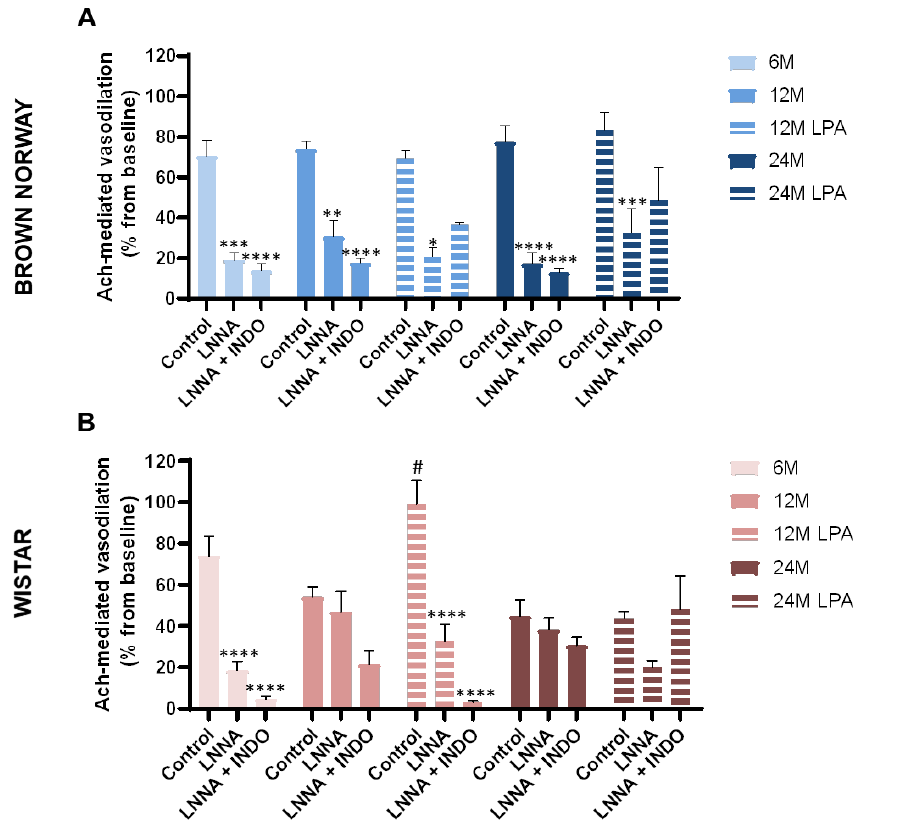
Figure 7. Evolution of the contribution of the NO synthase (NOS) and cyclooxygenase (COX) pathways in the Ach-mediated vasodilation over time with (hatched bars) or without (solid bars) LPA treatment. The effect of an NOS inhibitor (LNNA) in combination or not with a COX inhibitor (INDO) was analyzed on the vascular response to acetylcholine (Ach) iontophoresis in both BN ( A ) and Wistar strains ( B ) for 6 month old (6 M), 12 month old (12 M), and 24 month old (24 M) rats previously fed a diet supplemented with α -lipoic acid (0.5%) for 4 weeks (LPA) or not. In each condition, the blood flow was measured 1 min before and 16 min after iontophoresis. This allowed determining the vasodilation in response to Ach iontophoresis following injection of saline (control) and LNNA alone or in combination with INDO. Results were obtained as a percentage increase from baseline. Error bars represent the standard error of the mean. Statistical analysis was performed revealing significant differences after LPA treatment compared to age-matched untreated condition (# p < 0.05) and after LNNA or LNNA + INDO injection when compared to age-matched saline injection as control (* p < 0.05; ** p < 0.01; *** p < 0.001; **** p < 0.0001).